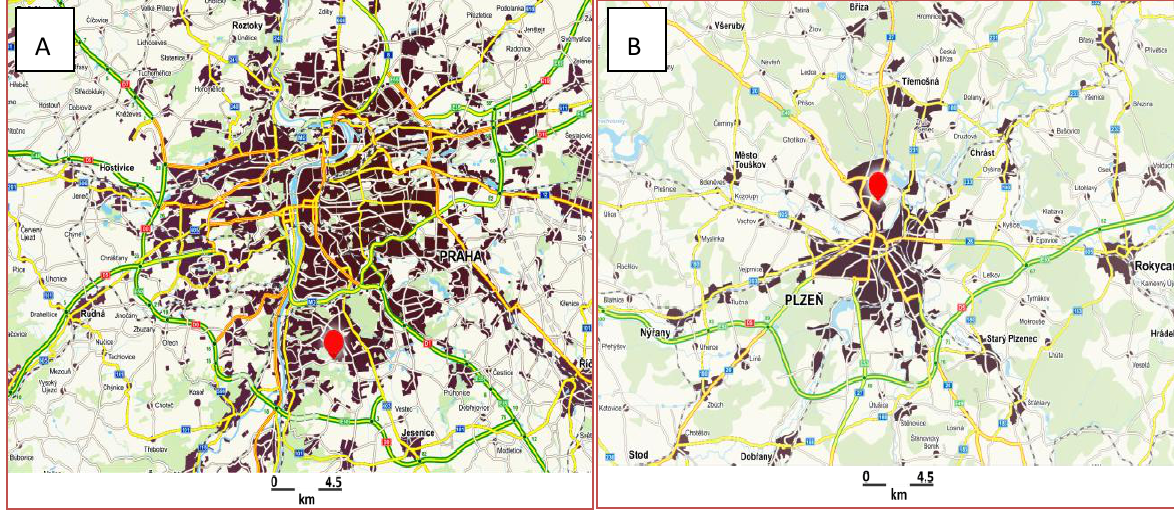
Fig. 3. Location of the two stations in the context of urbanization – Prague-Libuš (A) and Pilsen-Mikulka (B) (source: mapy.seznam.cz)